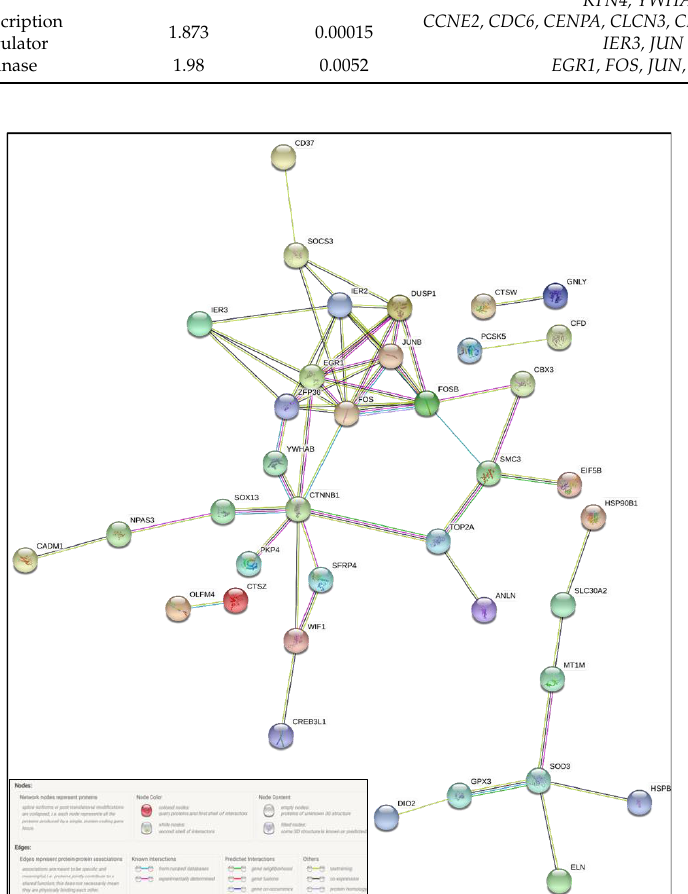
Figure 6. STRING-based protein – protein interaction (PPI) network of selected differentially expressed genes, showing predicted interconnectivities.